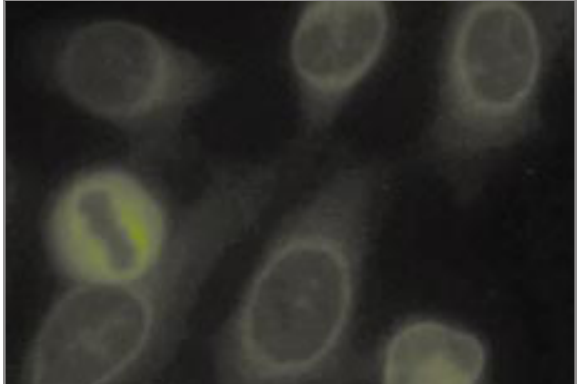
Figura 4 – Nuclear pontilhado pleomórfico